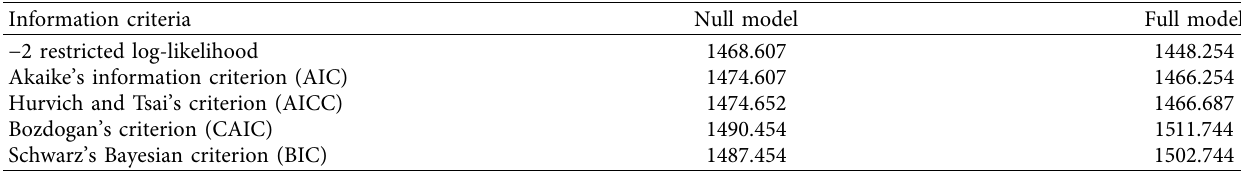
Table 5: The information criteria output from the takeover time model by LOS and curvature.